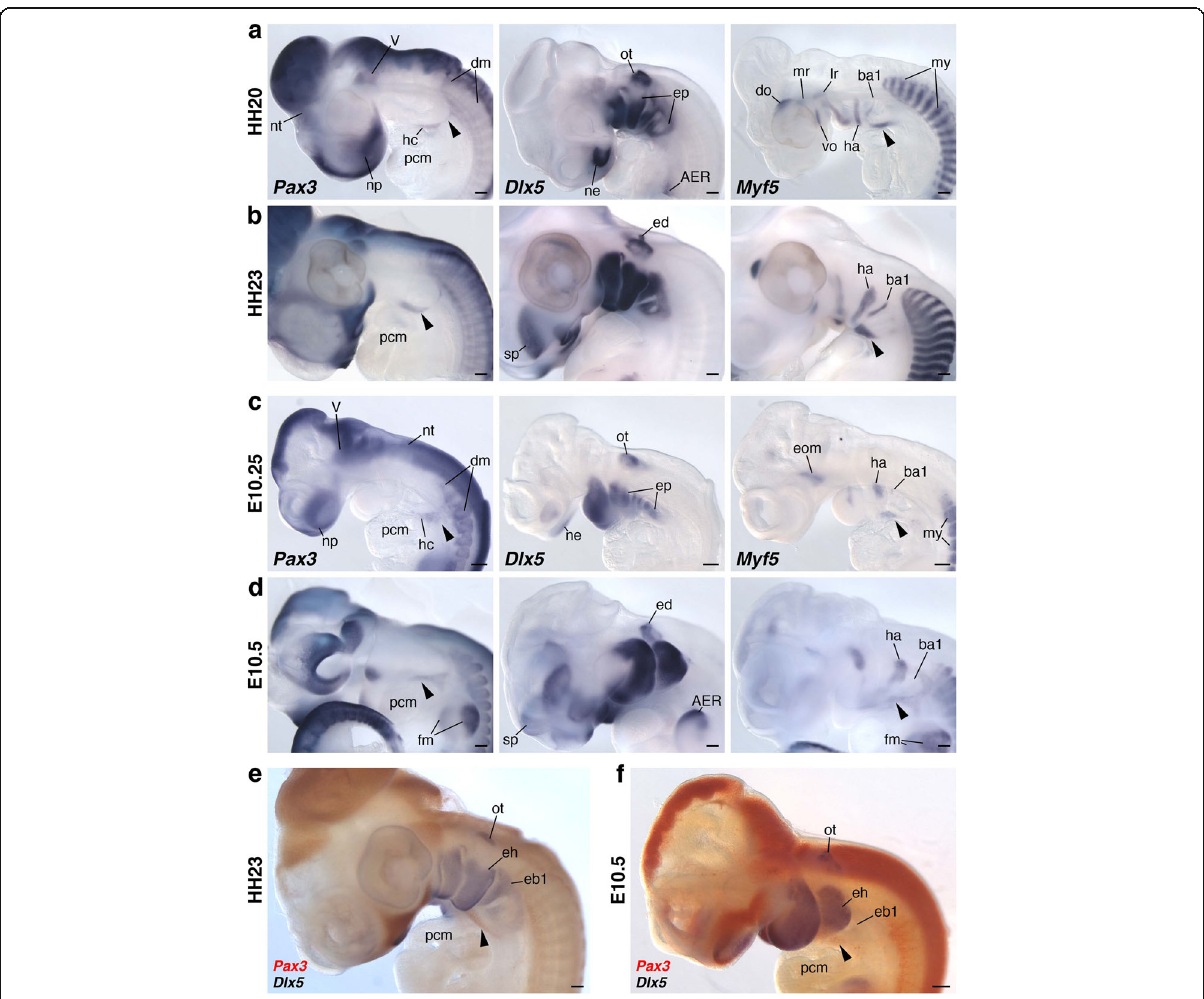
Fig. 2 Gene expression analysis of HBM precursors in chicken and mouse embryos. Pax3 , Dlx5 and Myf5 expression patterns in chicken HH20 ( a ) and HH23 ( b ), and mouse E10.25 ( c ) and E10.5 ( d ). Two-color in situ hybridization with Pax3 (red) and Dlx5 (blue) probes in chicken HH23 ( e ) and mouse E10.5 ( f ). Lateral views. Arrowheads indicate HBM precursors. Note that HBM precursors, marked by Pax3 and Myf5 expressions, developed medially at the level of hyoid arch at stage HH23 and E10.5 embryos. AER, apical ectodermal ridge; ba1, first branchial arch mesoderm; dm, dermomyotome; do, dorsal oblique; eb1, ectomesenchyme of first branchial arch; ed., endolymphatic duct; eh, ectomesenchyme of hyoid arch; ep, ectomesenchyme of pharyngeal arches; fm, forelimb muscles; ha, hyoid arch mesoderm; hc, hypoglossal cord; lr, lateral rectus; mr, medial rectus; my, myotome; ne, nasal epithelium; np, nasal prominence; nt, neural tube; ot, otic vesicle; pcm, pericardial mesoderm; sp., subpallium; V, trigeminal ganglion; vo, ventral oblique. Scale bars, 200 μ